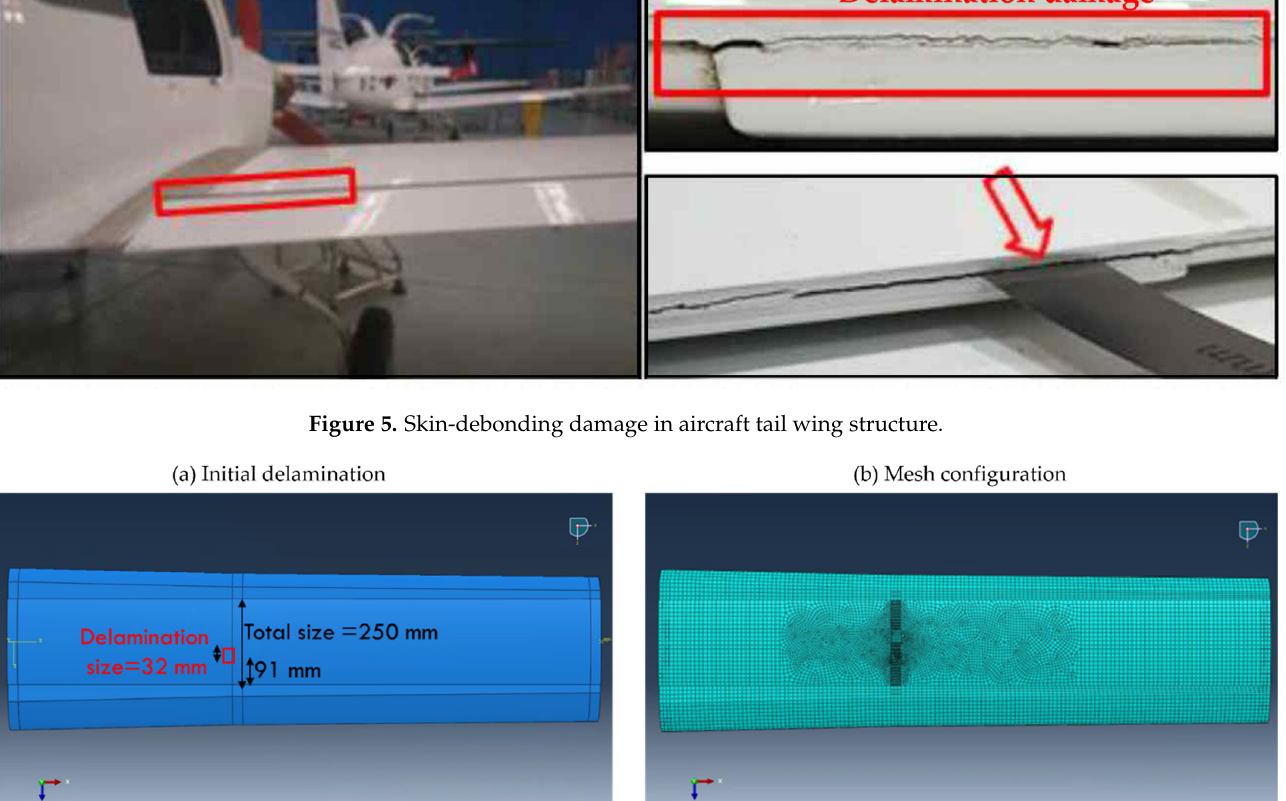
Figure 6. ( a ) Geometry of a tail wing with initial delamination and ( b ) the mesh configuration of the model.